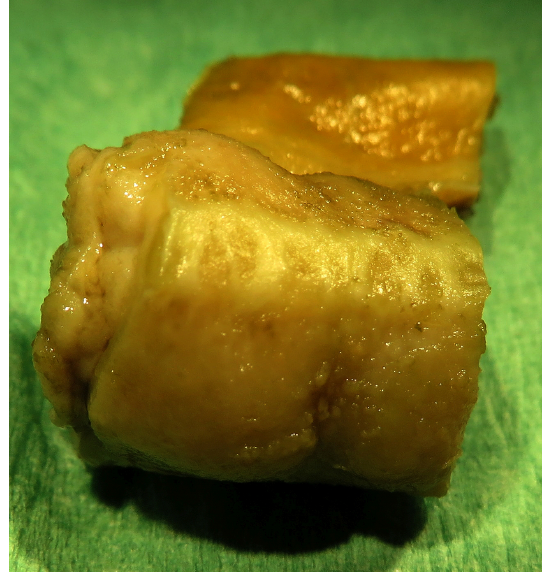
Figure 2. Formalin-fixed segment (1cm) of the jejunum of an African green monkey with multiple small nodules on the serosal